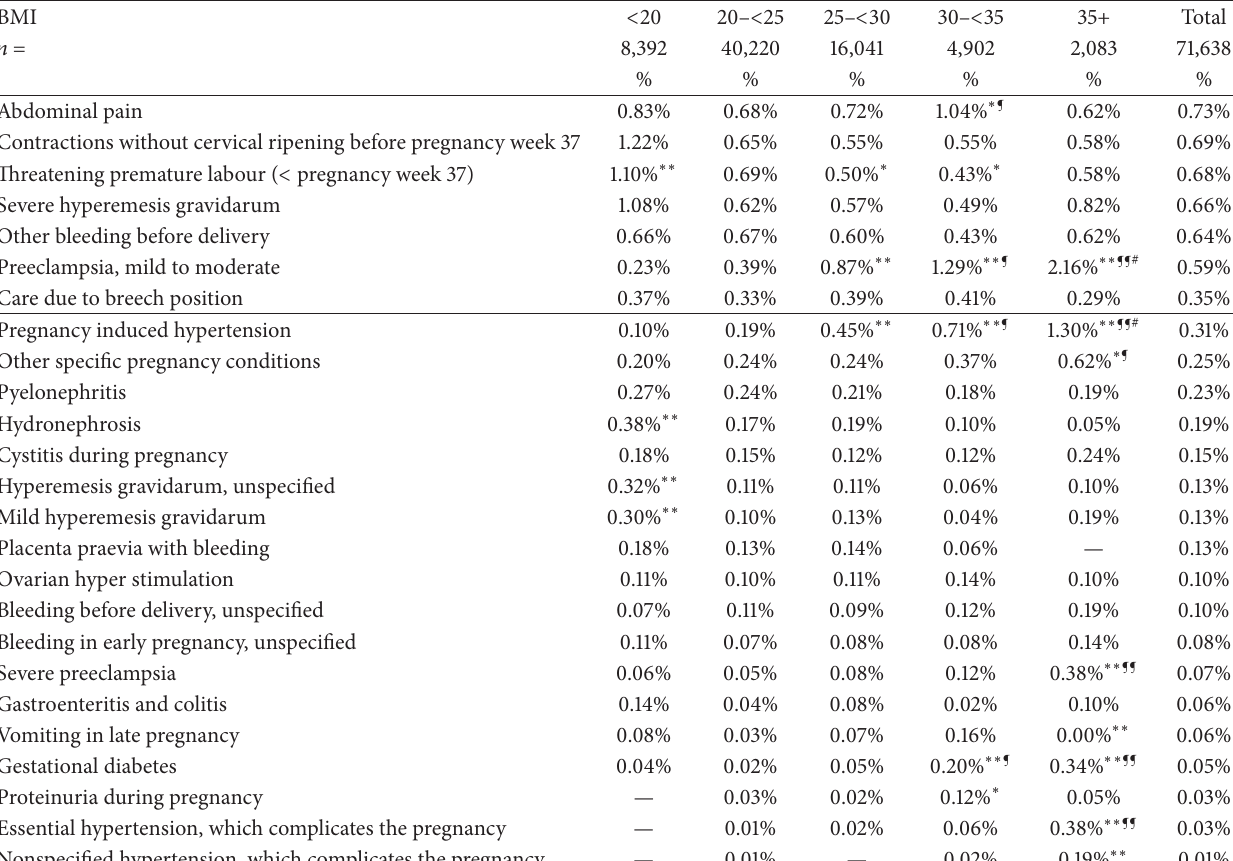
Table 3: Most common diagnoses for inpatient care hospital admissions in the entire study population.